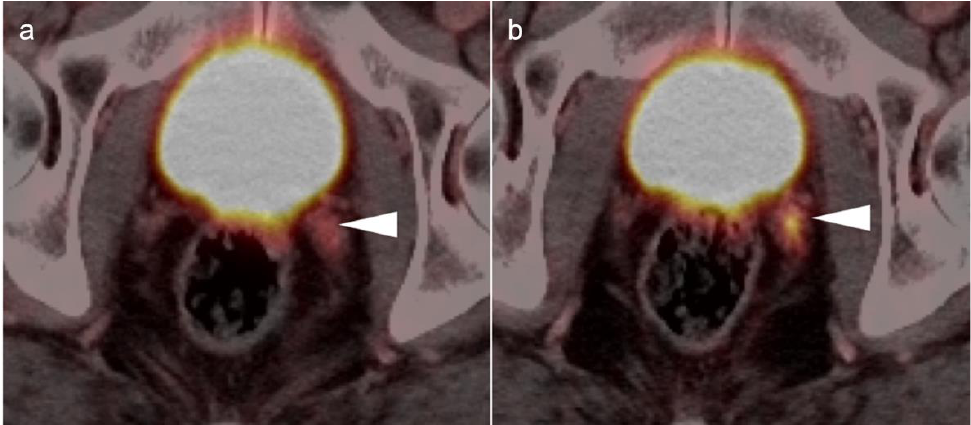
Figure 32. Gross extra-prostatic spread of prostate cancer to vas deferens and seminal vesicles on [ 18 F]-Fluciclovine PET-CT. ( a , b ) There is PET-positive tumor extending along the right vas deferens (white arrows); ( c ) tumor also involves both seminal vesicles (white arrowheads).